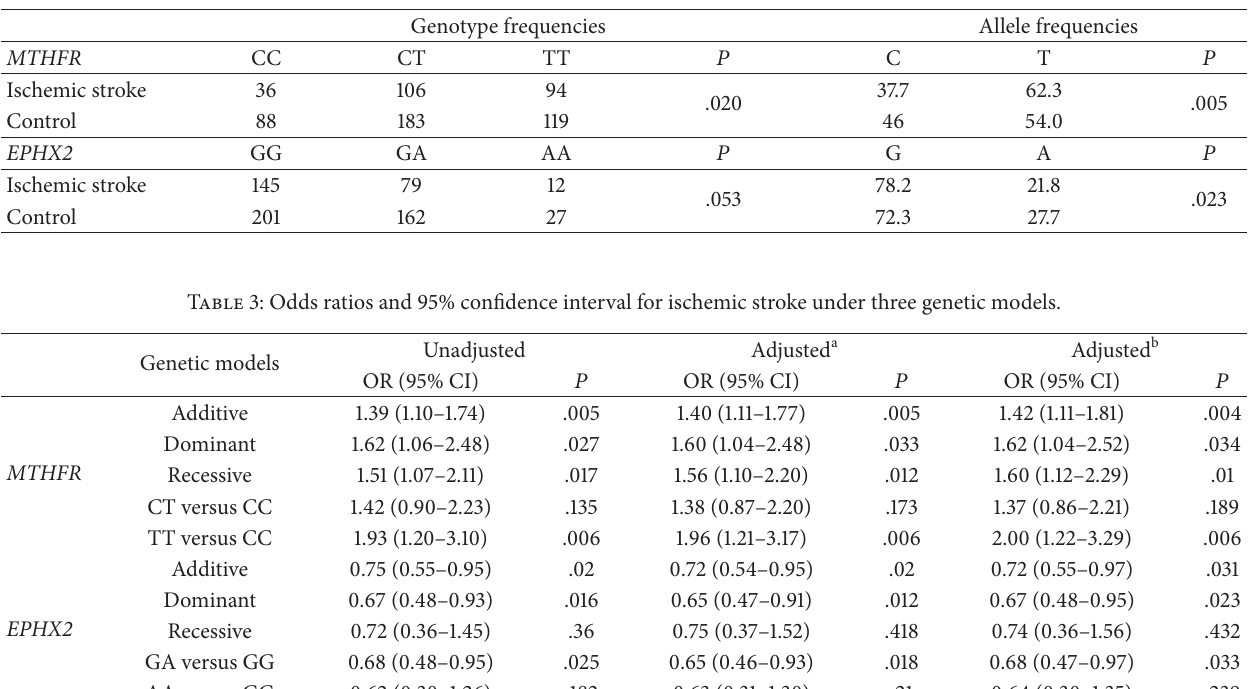
Table 2: Genotype distribution and allele frequency of MTHFR C677T and EPHX2 G860A in ischemic stroke and control groups.